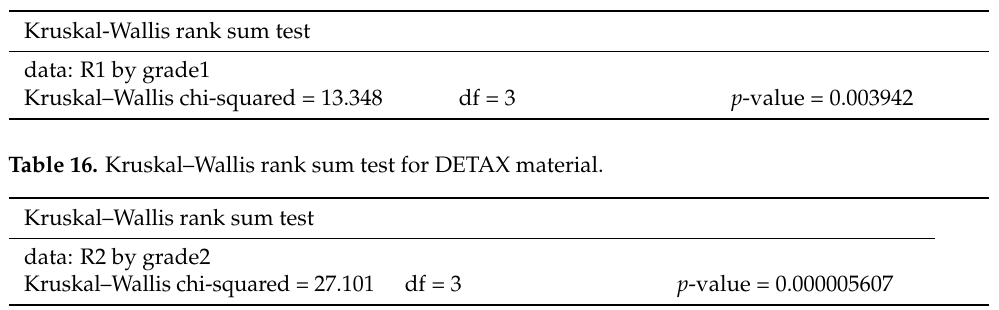
Table 15. Kruskal–Wallis rank sum test for NEXTDENT material.